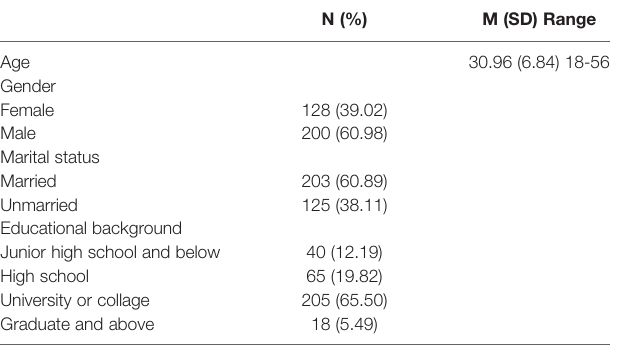
TABLE 1 | Demographic data of the sample.